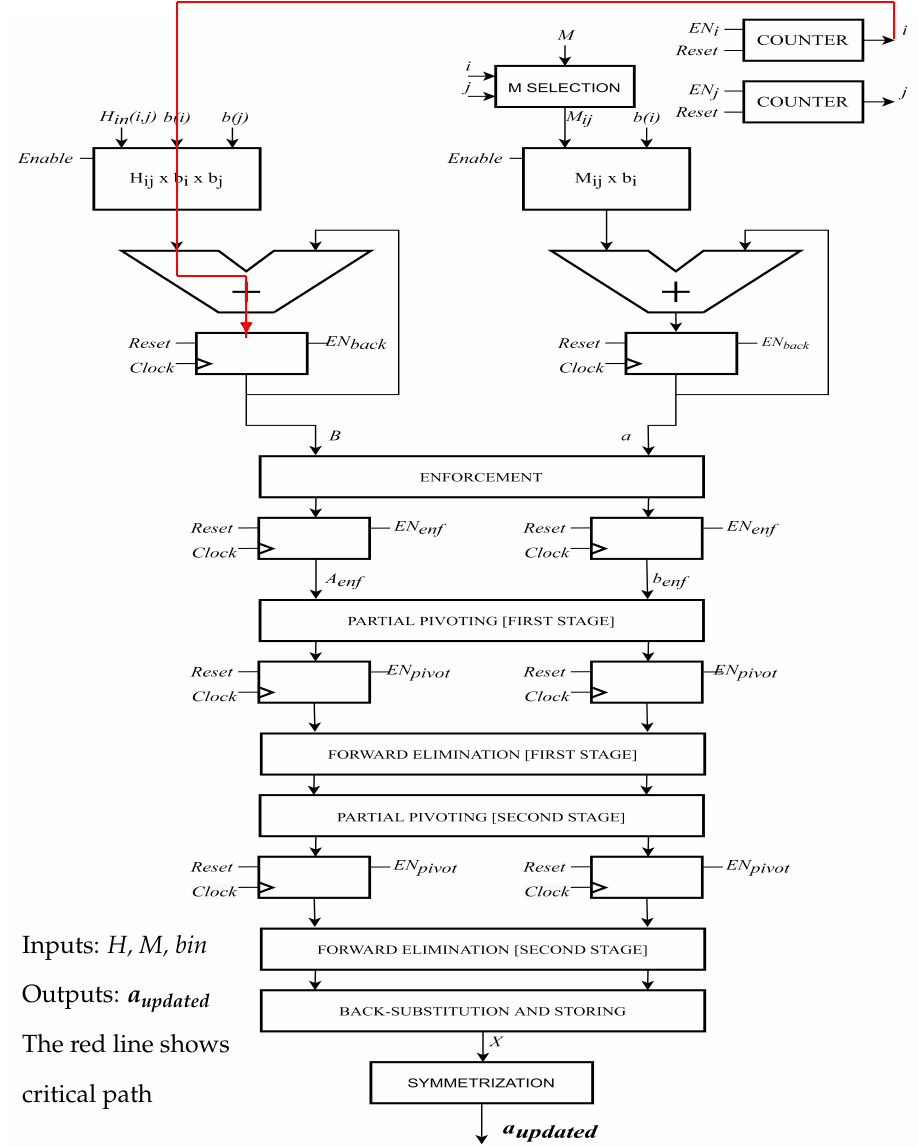
Figure 6. Updating a data